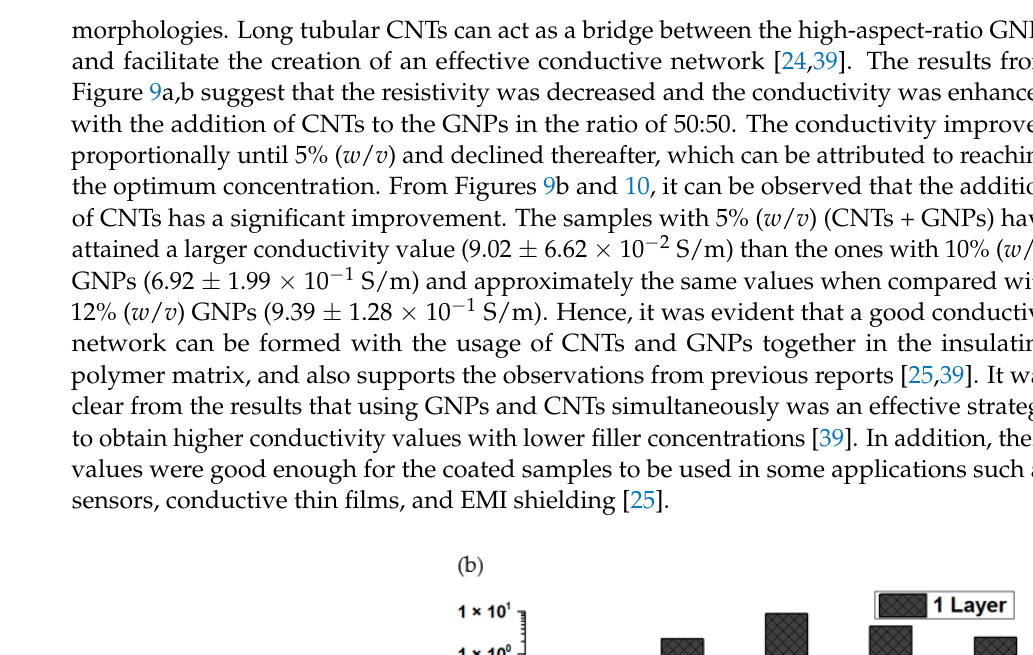
Figure 8. ( a ). Electrical resistivity of cotton fabrics coated with GNPs; ( b ). Electrical conductivity of cotton fabrics coated with GNPs.